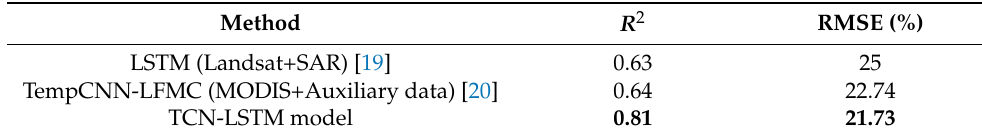
Table 4. Comparison of different LFMC retrieval